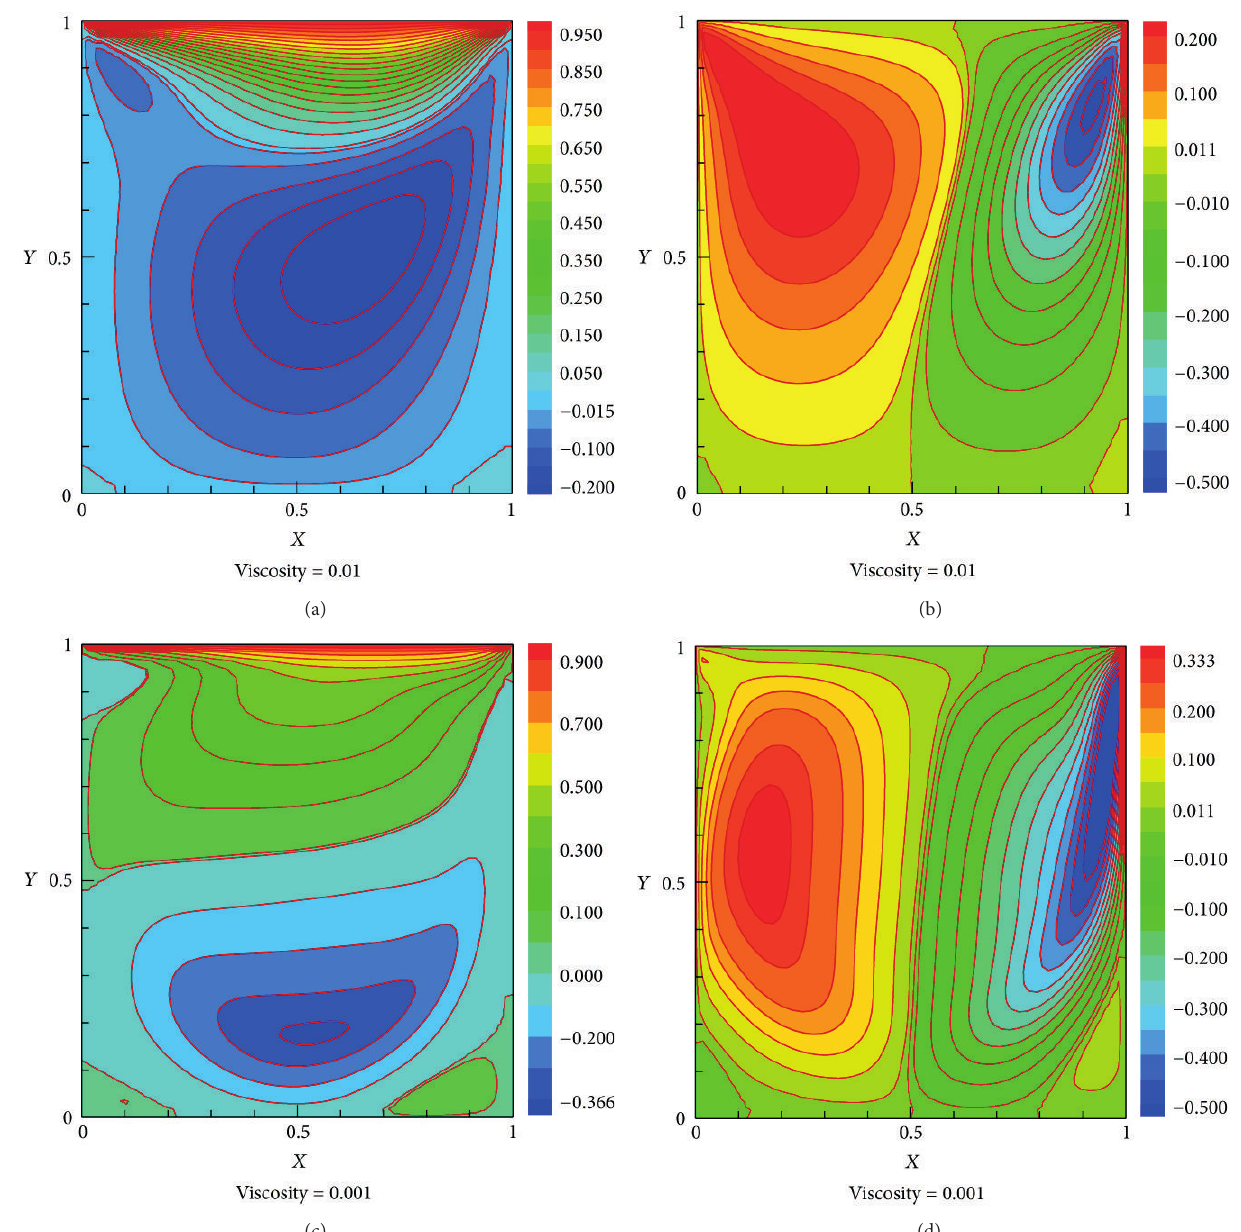
Figure 9: Mean values of horizontal ((a) and (c)) and vertical ((b) and (d)) velocities for 𝑃 = 2 and 𝑀 = 2 .